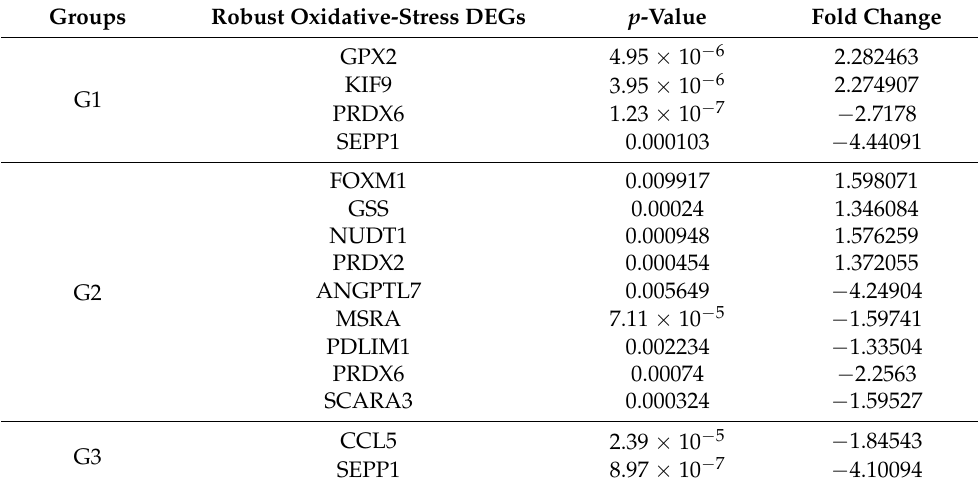
Table 6. Robust oxidative stress-related DEGs from